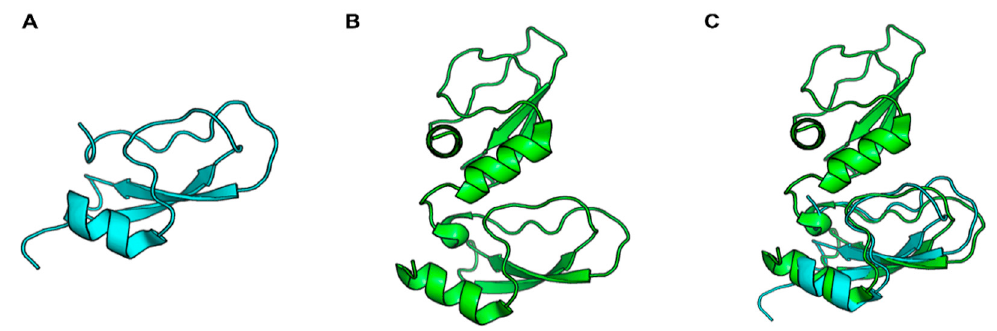
Figure 1. Cartoon representation of the second Kunitz domain of human TFPI (PDB: 1TFX) ( A ), the two Kunitz domains of Ixolaris (PDB: 6NAN) ( B ), and the superposition of the two mentioned Kunitz domains ( C ).